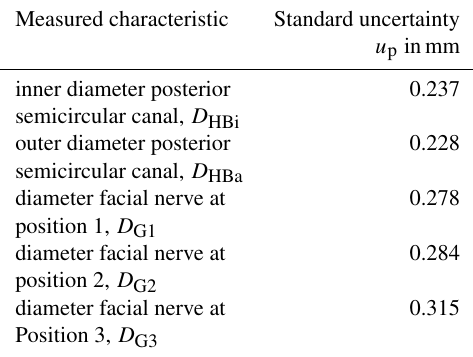
Table 2. Standard uncertainties of the measuring method for differ- ent measuring tasks.